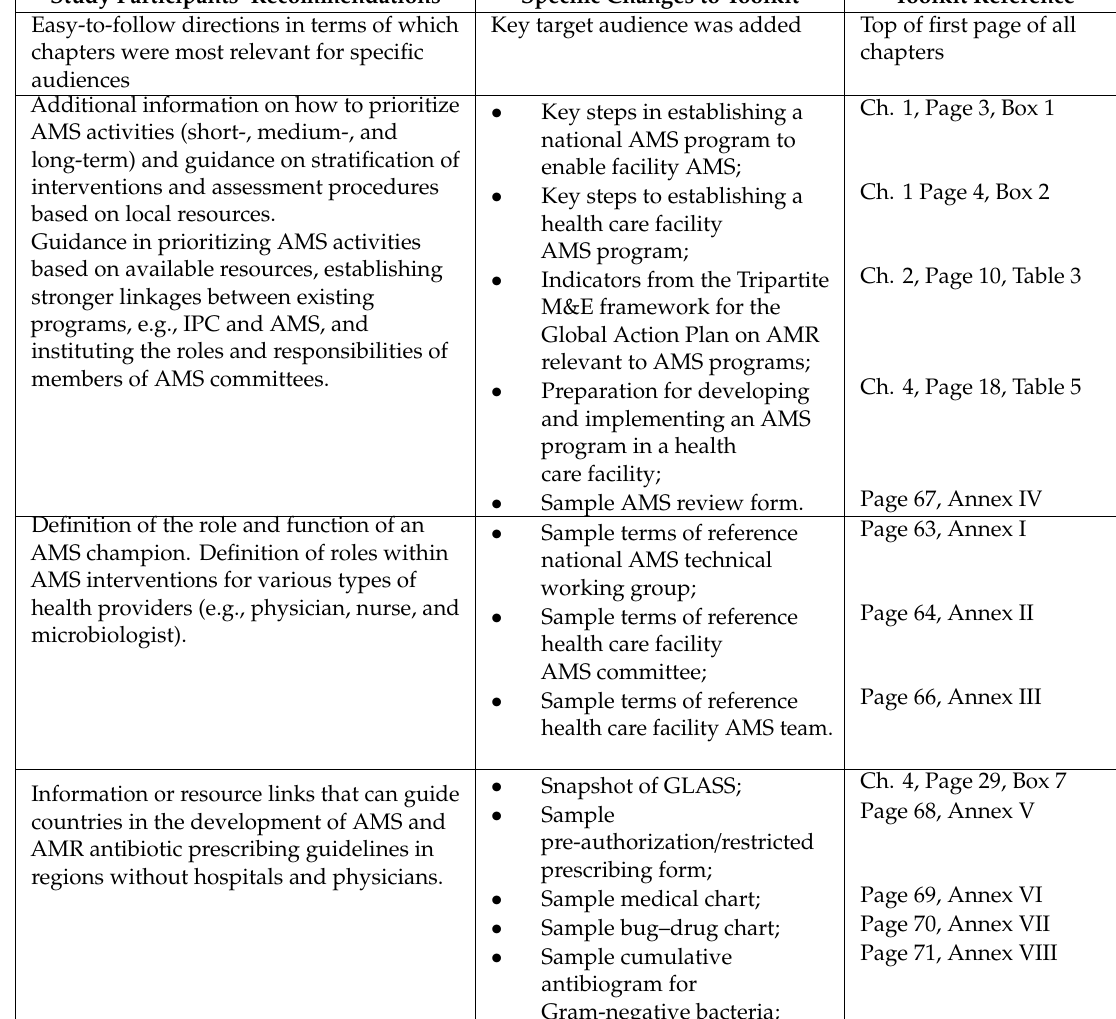
Table 4. Key recommendations and implemented changes in the WHO AMS